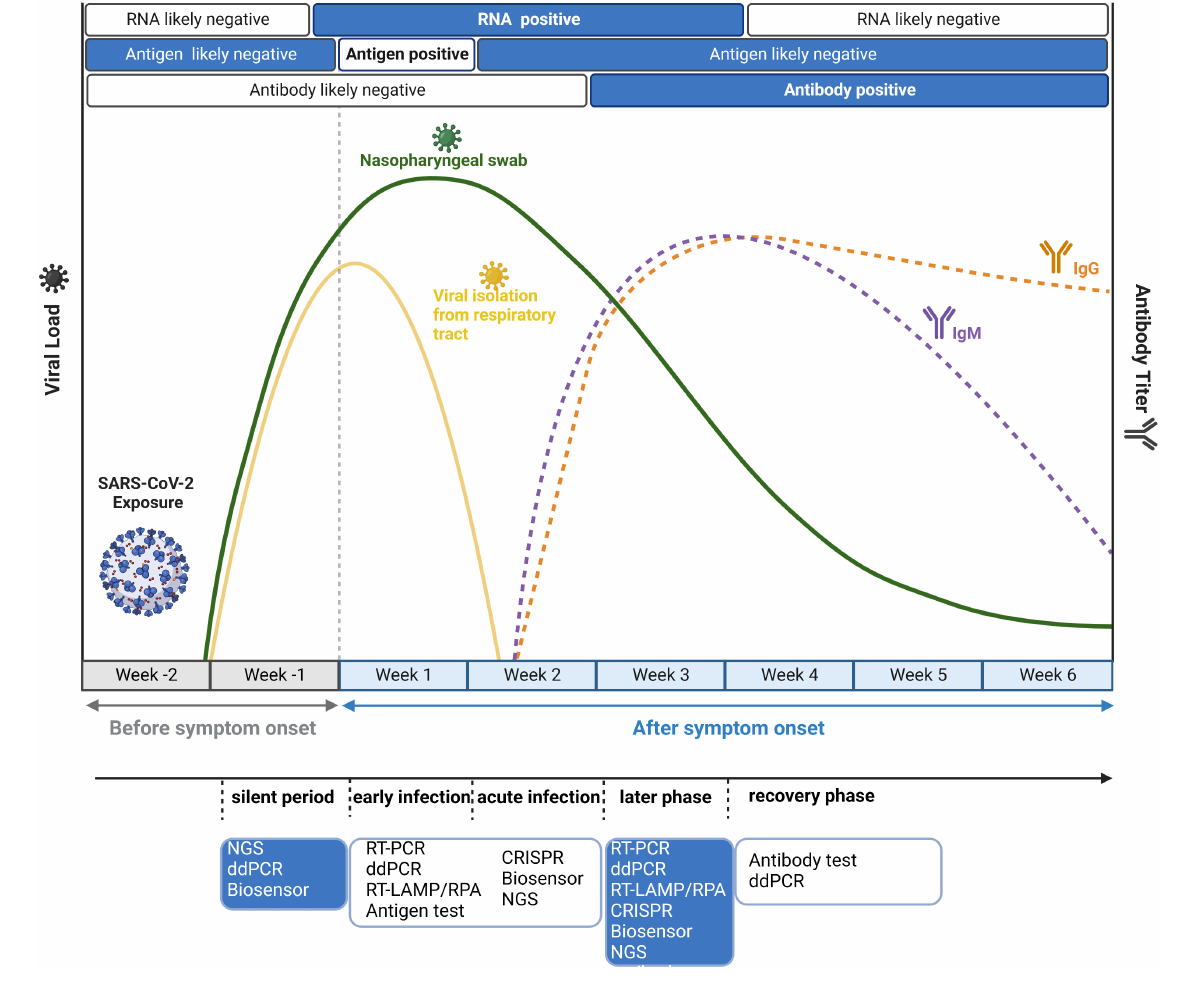
FIGURE4 Disease dynamics and optional diagnostic tests for COVID-19. Because of virus load and antibody dynamics, it is necessary to adopt different detection strategies at different time points. Before symptom onset, the optimal choice is nucleic acid testing because its limit of detection (LOD) can reach 10 2 –10 3 copies/ml. After symptom onset, antigen tests and viral RNA detection are all feasible in the first week, while antibody tests are positive later in the disease